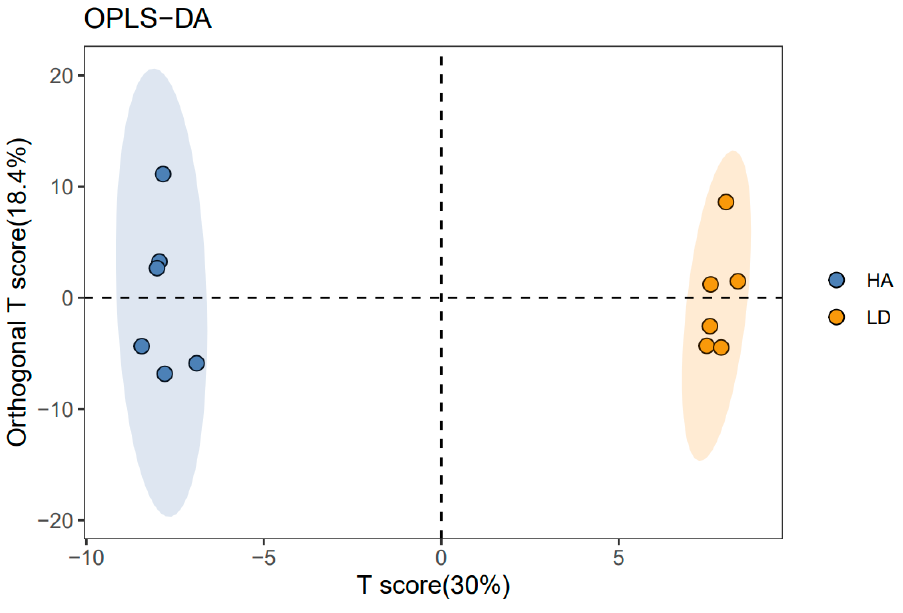
Figure 5. OPLS-DA score map of bayberry rhizosphere soil of the compound humic acid treatment. LD and HA represent the absence and presence of humic acid in diseased bayberry trees, respec- tively.